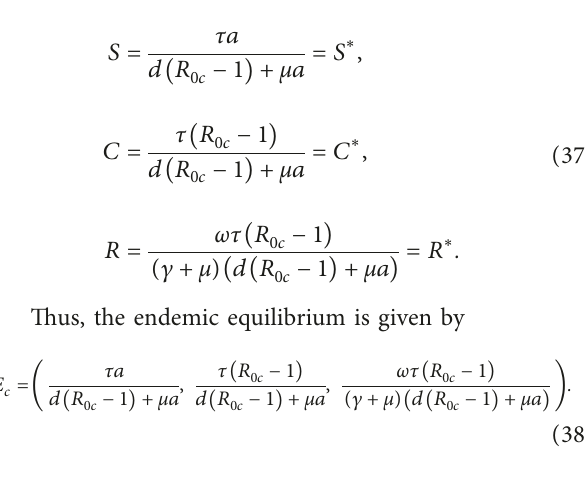
Figure 3: Forward bifurcation of cholera only model at R